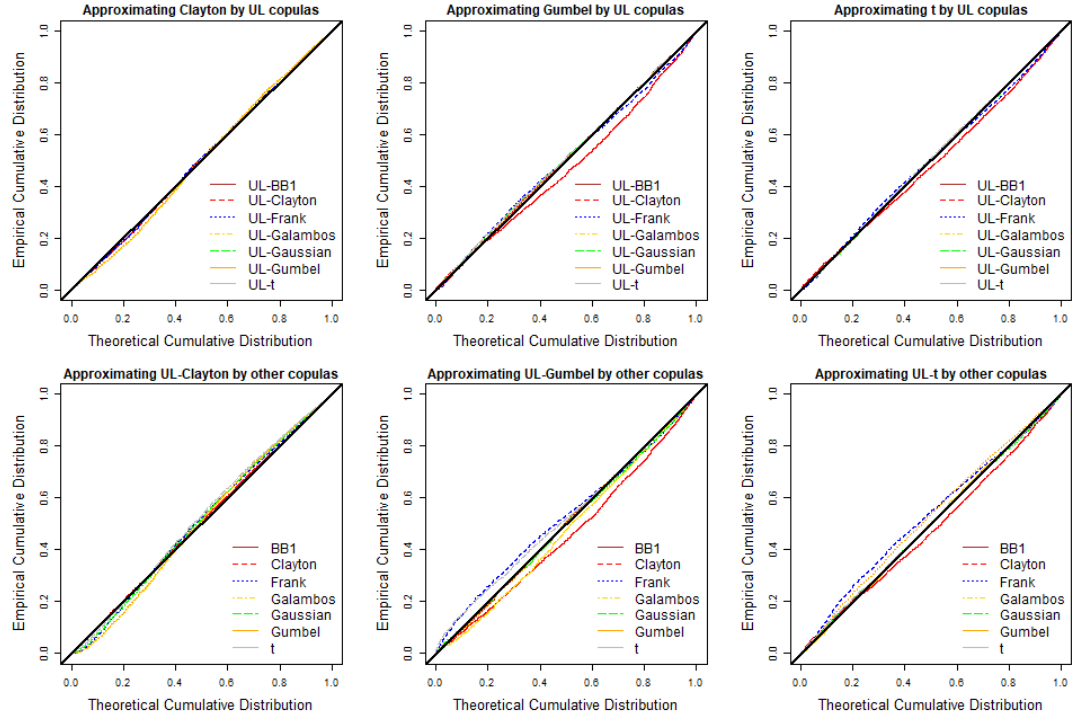
Figure 5. P-P plots of the empirical cumulative distribution and estimated cumulative distribution for various theoretical models. The first row displays the results from fitting data generated from the Clayton, Gumbel, and t copulas. The second row is from the UL-Clayton, UL-Gumbel, and